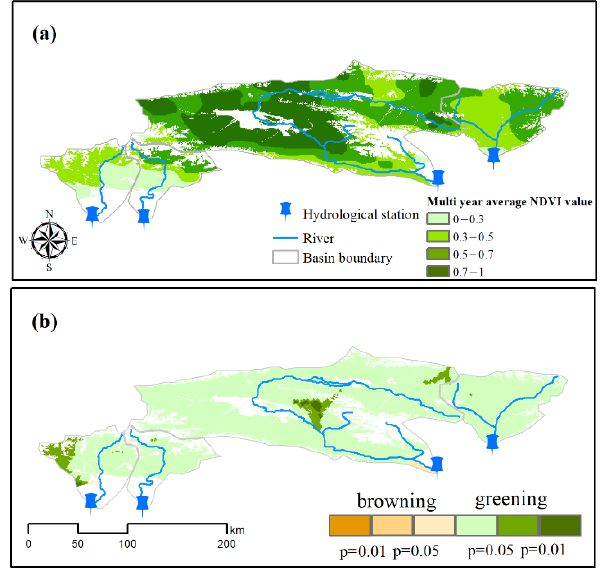
Figure A2. Multiyear average (a) and change trends (b) in NDVI values derived from GIMMS for the four basins during 1983−2012. p (browning) and p (greening) are the significance of the decrease and increase in NDVI values examined by the MK test. p values are divided into three levels: p < 0.01, 0.01 < p < 0.05, and p > 0.05.